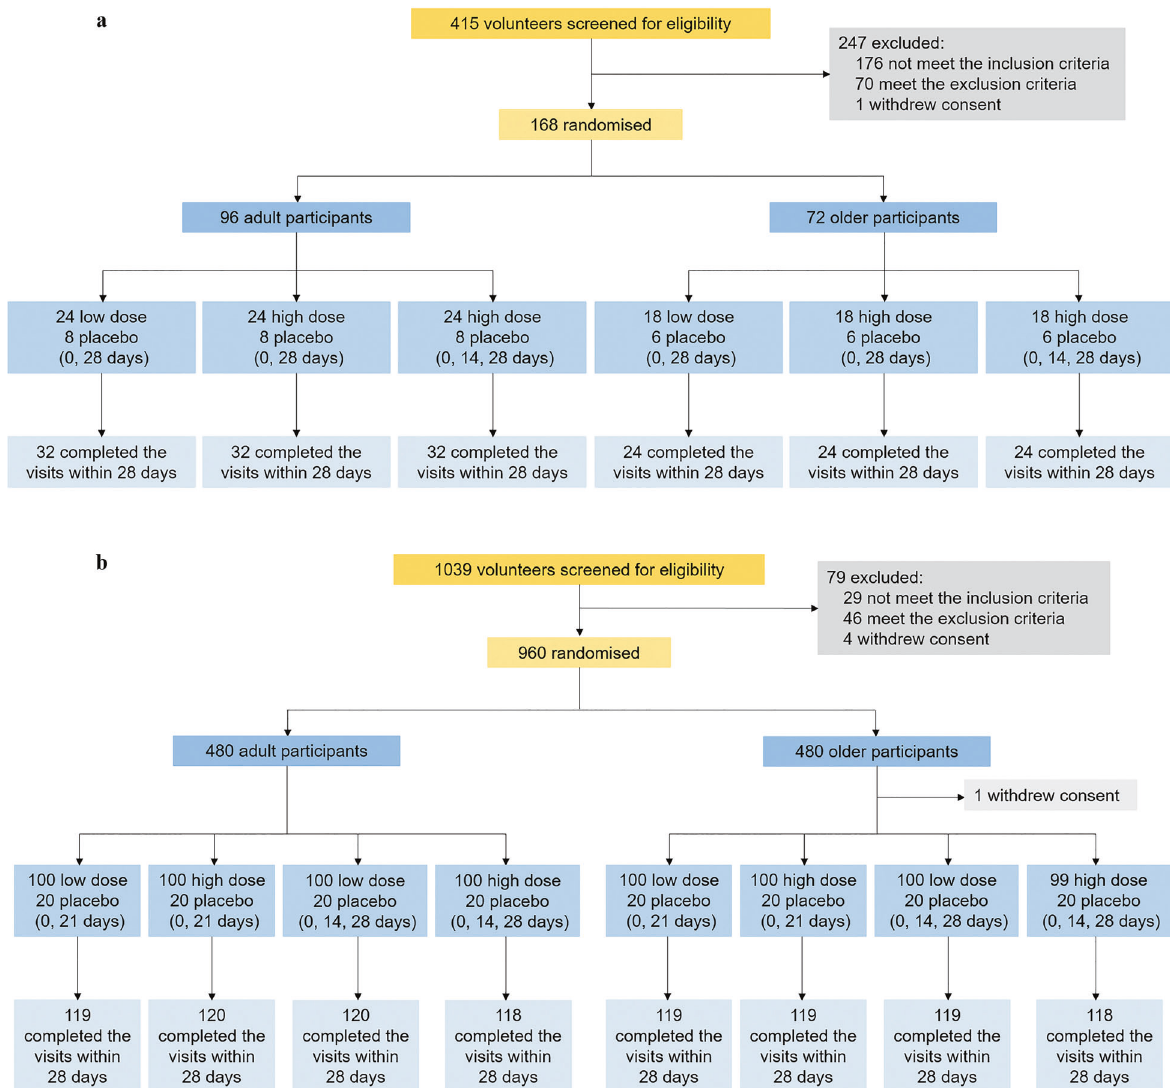
Fig. 1 Trial pro fi le. a In phase 1 trial, 415 volunteers were recruited and screened for eligibility, among which 168 participants were sequentially enrolled and randomly assigned. All participants completed the full doses of vaccination and the planned visits within 28 days after the last dose vaccination. b In phase 2 trial, 1039 volunteers were recruited and screened for eligibility, among which 960 participants were enrolled and randomly assigned. 959 participants received the fi rst dose vaccination, with 1 participant refused to receive vaccination after randomization. 952 participants completed the full doses of vaccination and the planned visits within 30 days after the last dose